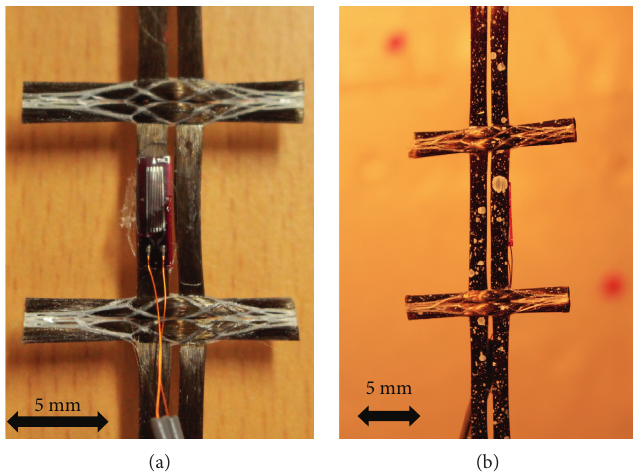
Figure 3: Back and front surfaces of the BFRP grid. (a) Surface for strain gauge. (b) Sprayed surface for DIC.